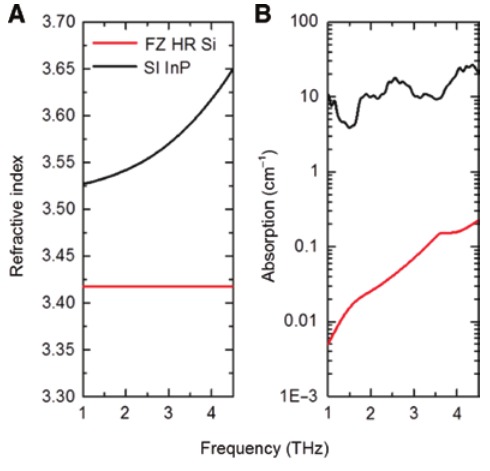
Figure 8: Comparison of HR-FZ Si and SI InP substrates. The refractive indices (A) and optical absorption (B) of HR-FZ Si (red) and SI InP (blue) as a function of frequency